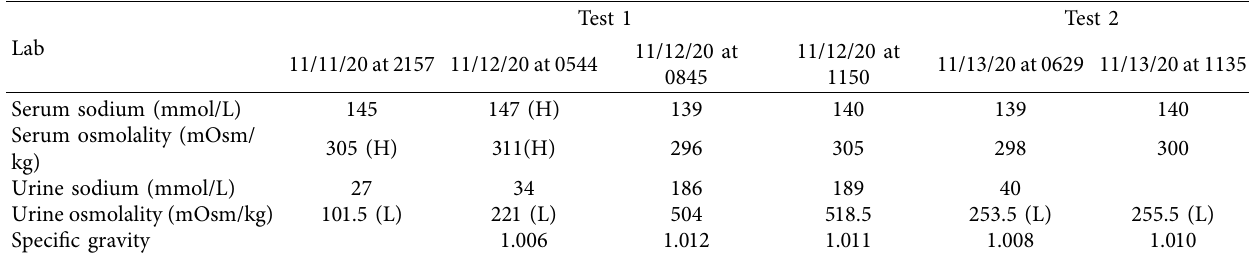
Table 2: Water deprivation test